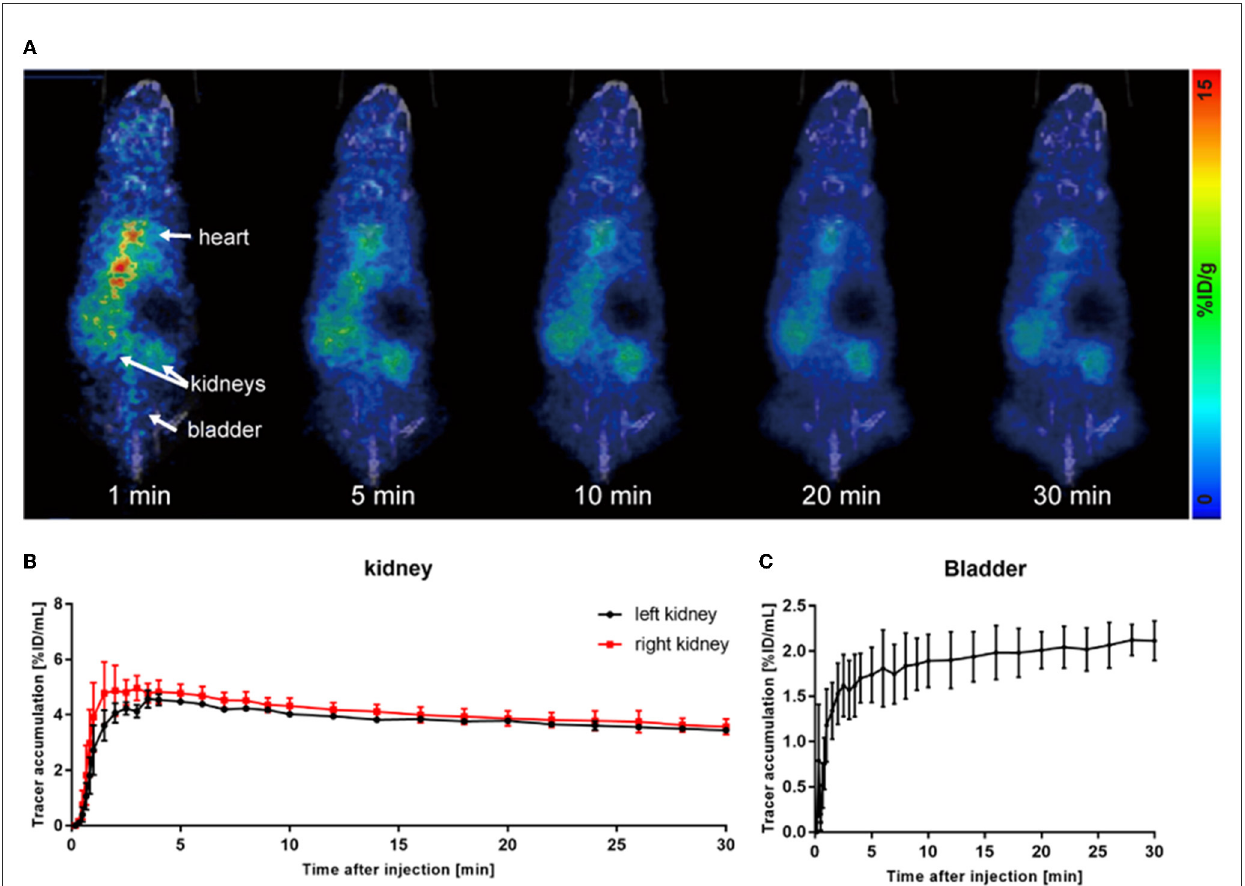
FIGURE2 68 Ga-EDTA dynamic PET/CT imaging of acute kidney injury (AKI) mice. (A) Coronal fusion images of 68 Ga-EDTA dynamic PET/CT scanning in AKI mice. (B) The renograms of AKI mice were obtained via PET imaging. (C) The bladder TAC of AKI mice was obtained via PET imaging.